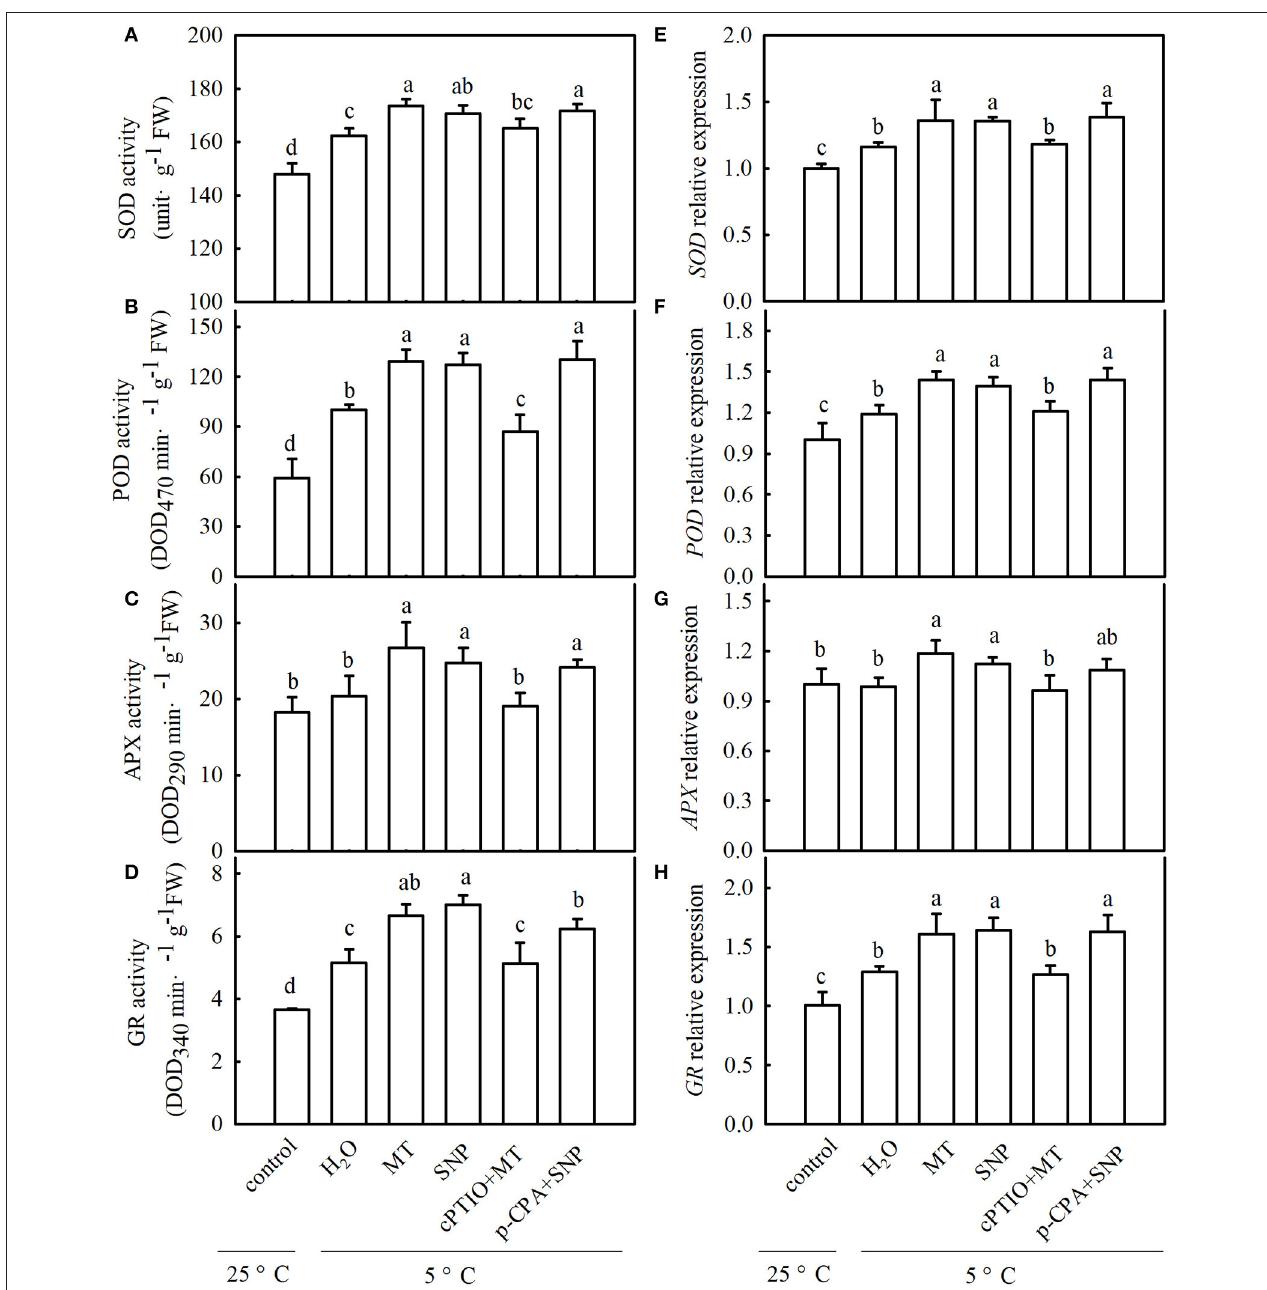
FIGURE 9 | Interactive effects of MT and SNP on activities and relative mRNA expression of antioxidant enzymes in cucumber seedlings under cold stress. (A–D) Activities of superoxide dismutase (SOD), peroxidase (POD), ascorbate peroxidase (APX), and glutathione reductase (GR), respectively. (E–H) Relative mRNA expression of SOD , POD , APX , and GR, respectively. Three-leaf stage seedlings were foliar sprayed with 100 µ M MT, 75 µ M SNP, 100 µ M cPTIO + 100 µ M MT, 50 µ M p-CPA + 75 µ M SNP, or deionized water (control) for 24h and then were exposed to 5 ◦ C for 48h. Data are represented as mean ± SD ( n = 3). Different letters indicate a significant difference between samples according to Duncan’s new multiple range test ( p <